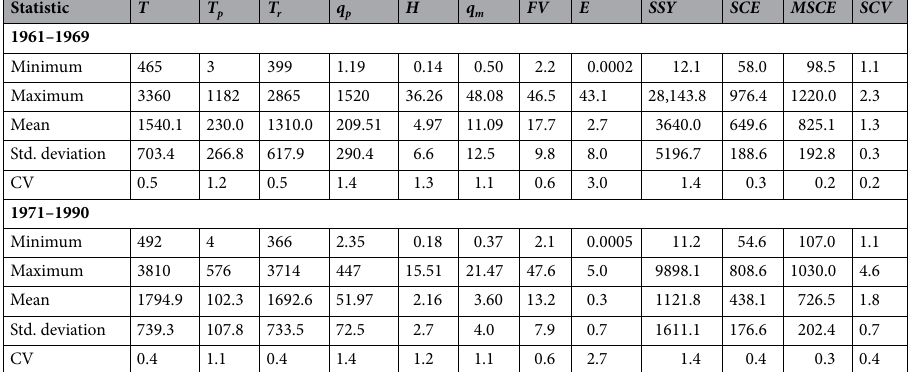
Table 1. Descriptive statistics of the characteristics of event-based flood flows and sediment in 1961–1990 (excluding 1970). There were 49 and 82 recorded events in 1961–1969 and 1971–1990, respectively, included in the statistical analyses. CV coefficient of variation; T flood event duration, in min; T p time-to-peak, in min; T r duration of recession, in min; q p peak discharge, in m 3 s −1 ; H runoff depth, in mm; q m mean discharge, in m 3 s −1 ; FV flow variability, which is defined as the ratio of the event-based flood peak discharge to mean discharge; E runoff erosion power, in m 4 s −1 ; SSY area-specific sediment yield, in t km −2 ; SCE average suspended sediment concentration, in kg m −3 ; MSCE maximum suspended sediment concentration, in kg m −3 ; SCV sediment variability, which is defined as the ratio of the maximum to average suspended sediment concentration at the event timescale. The same note also applies to Table